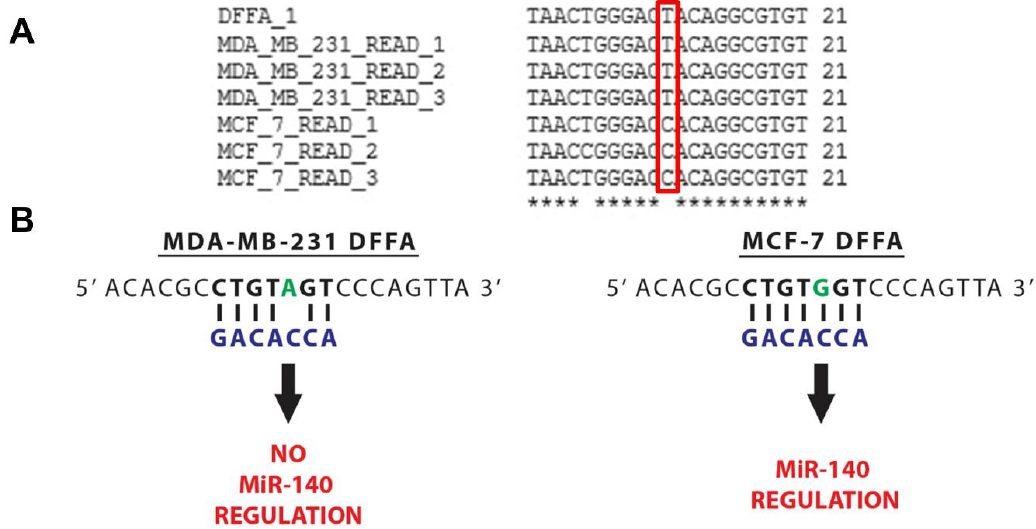
Figure 5. MiR-140 can regulate DFFA in MCF-7, but not MDA-MB-231. ( A ) Alignment of 21 nt segments of six RNA-Seq reads (three from each cell line) to a portion of the apoptosis inducing gene DFFA. Our edit identification algorithm identified an A-to-G edit site at basepair 10,460,668 on Chromosome 1, and corresponding reads mapping to that location were extracted and trimmed to 21 bp (edit site plus/minus 10 bp flanking regions). Edit location is outlined in red. The alignment was generated via ClustalW [40]. ( B ) Illustration showing complimentary base pairing between the miR-140 seed (blue) and the DFFA gene in both cell lines. The edit site is indicated in green.